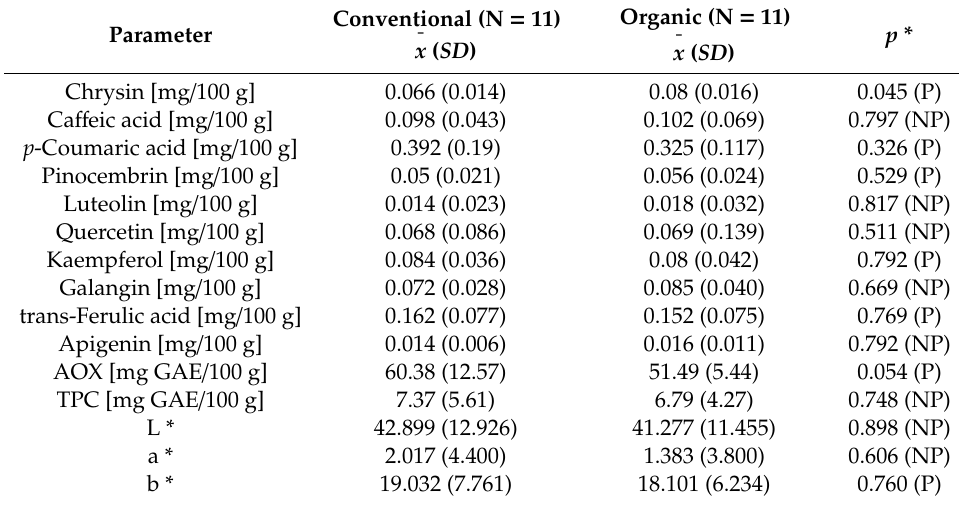
Table 3. Phenolic profiles, total phenols content (TPC), total antioxidant activity (AOX), and color parameters (L*, a*, b*) of organic and conventional honeys of Polish origin .